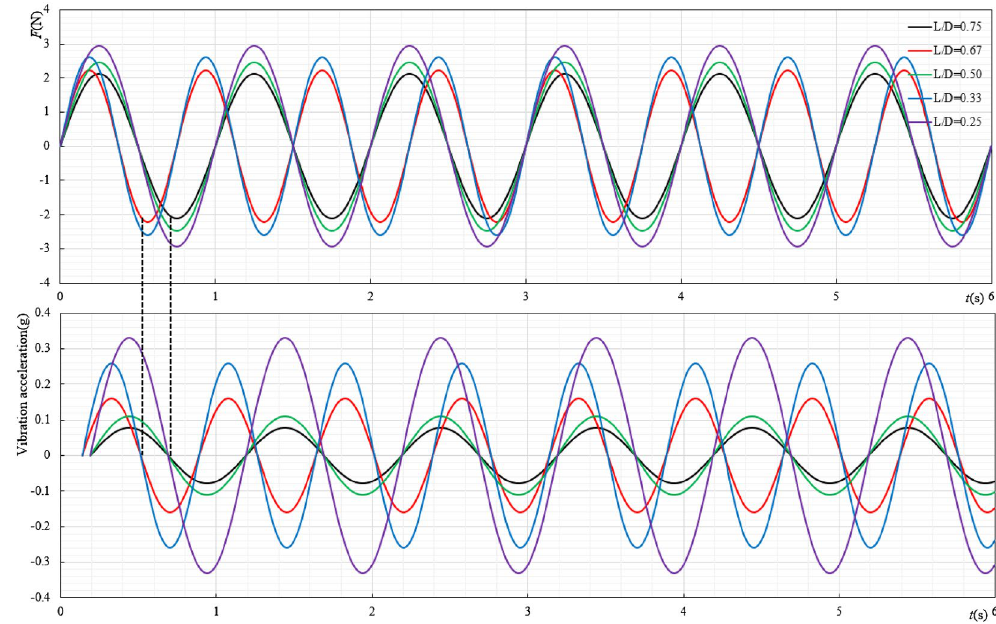
Figure 6. f 0.25 = f 0.5 = f 0.75 = 1Hz , f 0.33 = f 0.67 = 1.33Hz , the variation diagram of force and acceleration under different length-diameter ratios.